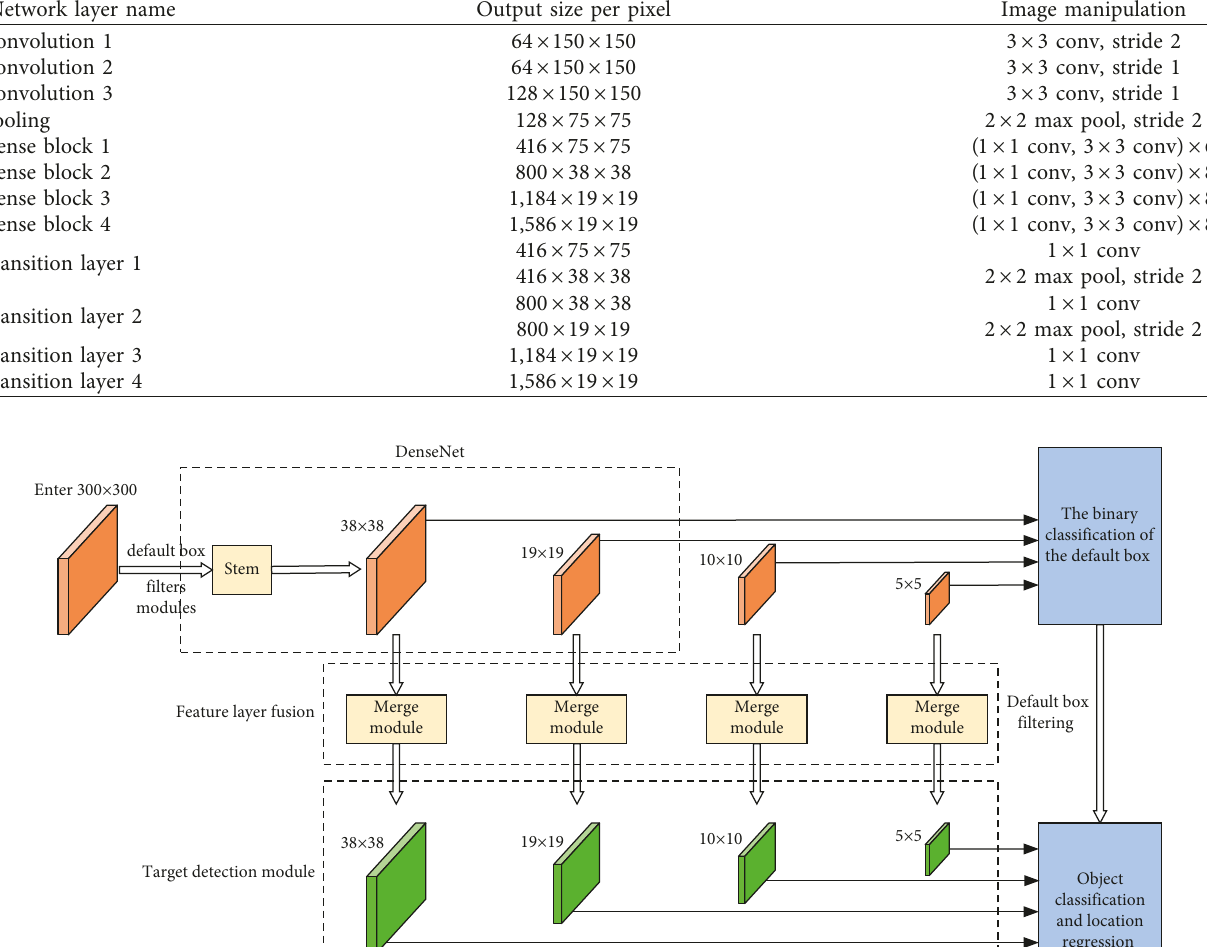
Table 1: Network layer parameters of improved